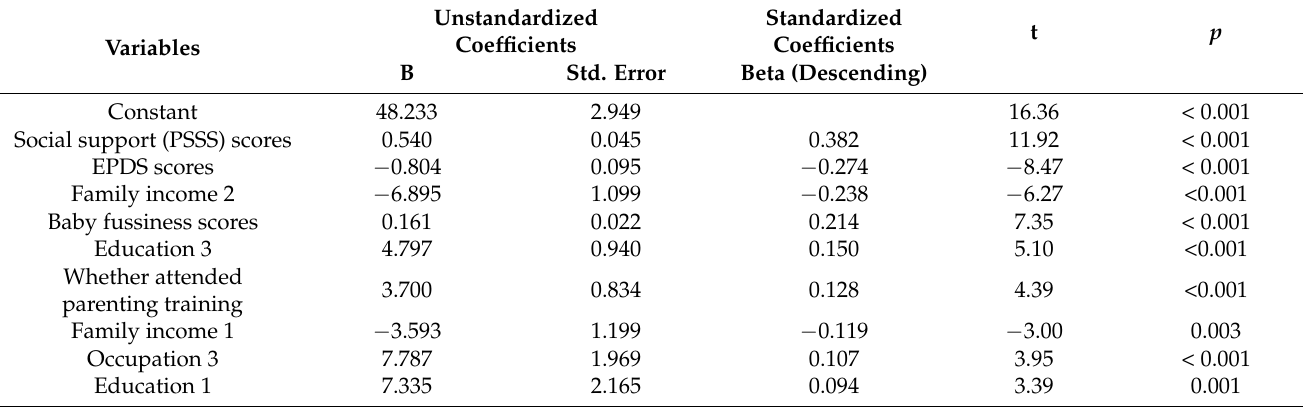
Table 2. The regression results of maternal self-efficacy (MSE) scores at six weeks postpartum ( n =